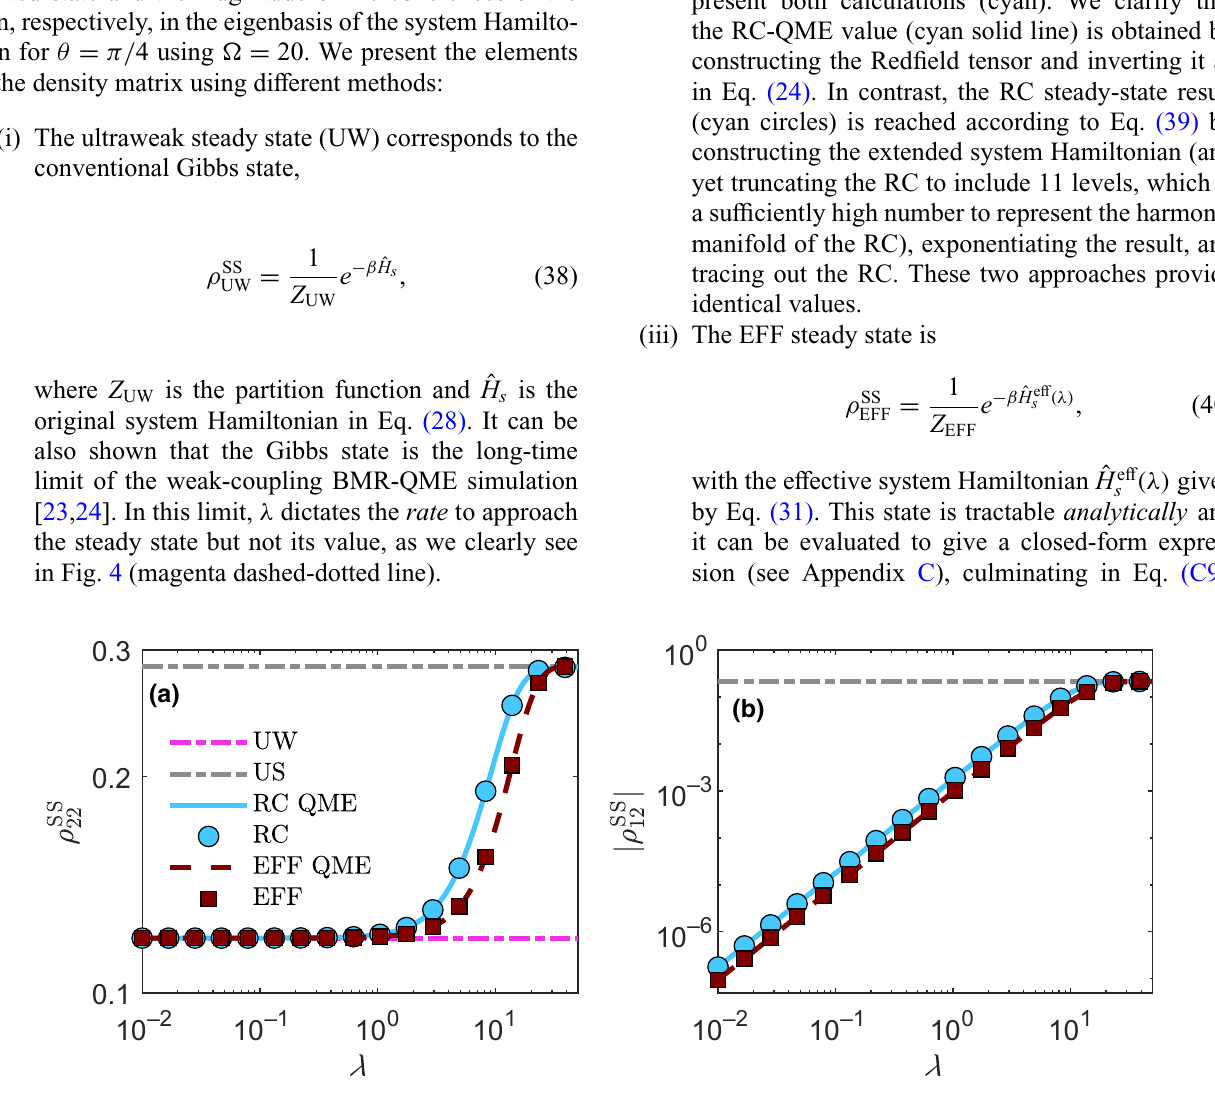
FIG. 4. The thermalization in the generalized spin-boson model. We present (a) the population and (b) the coherence in the eigen- basis of the Hamiltonian of the spin using two limiting cases of the steady state: the ultraweak-coupling limit [Eq. (38)] (UW, magenta dashed-dotted line) and the ultrastrong limit of Ref. [26] (US, light-gray dashed-dotted line). We further show the numerical RC QME, where the Redfield equation is solved after performing a reaction-coordinate mapping (solid line), as well as its steady-state approx- imation [Eq. (39)] (cyan circles). We also display the EFF-QME results, where the Redfield QME is once again implemented after the RCPT method (dashed line) as well as its steady-state approximation [Eq. (40)] (maroon squares). The parameters are (cid:11) = 1, θ = π/ 4 γ = 0.0071, (cid:5) = 20, (cid:10) = 1000, and T = (cid:11)/